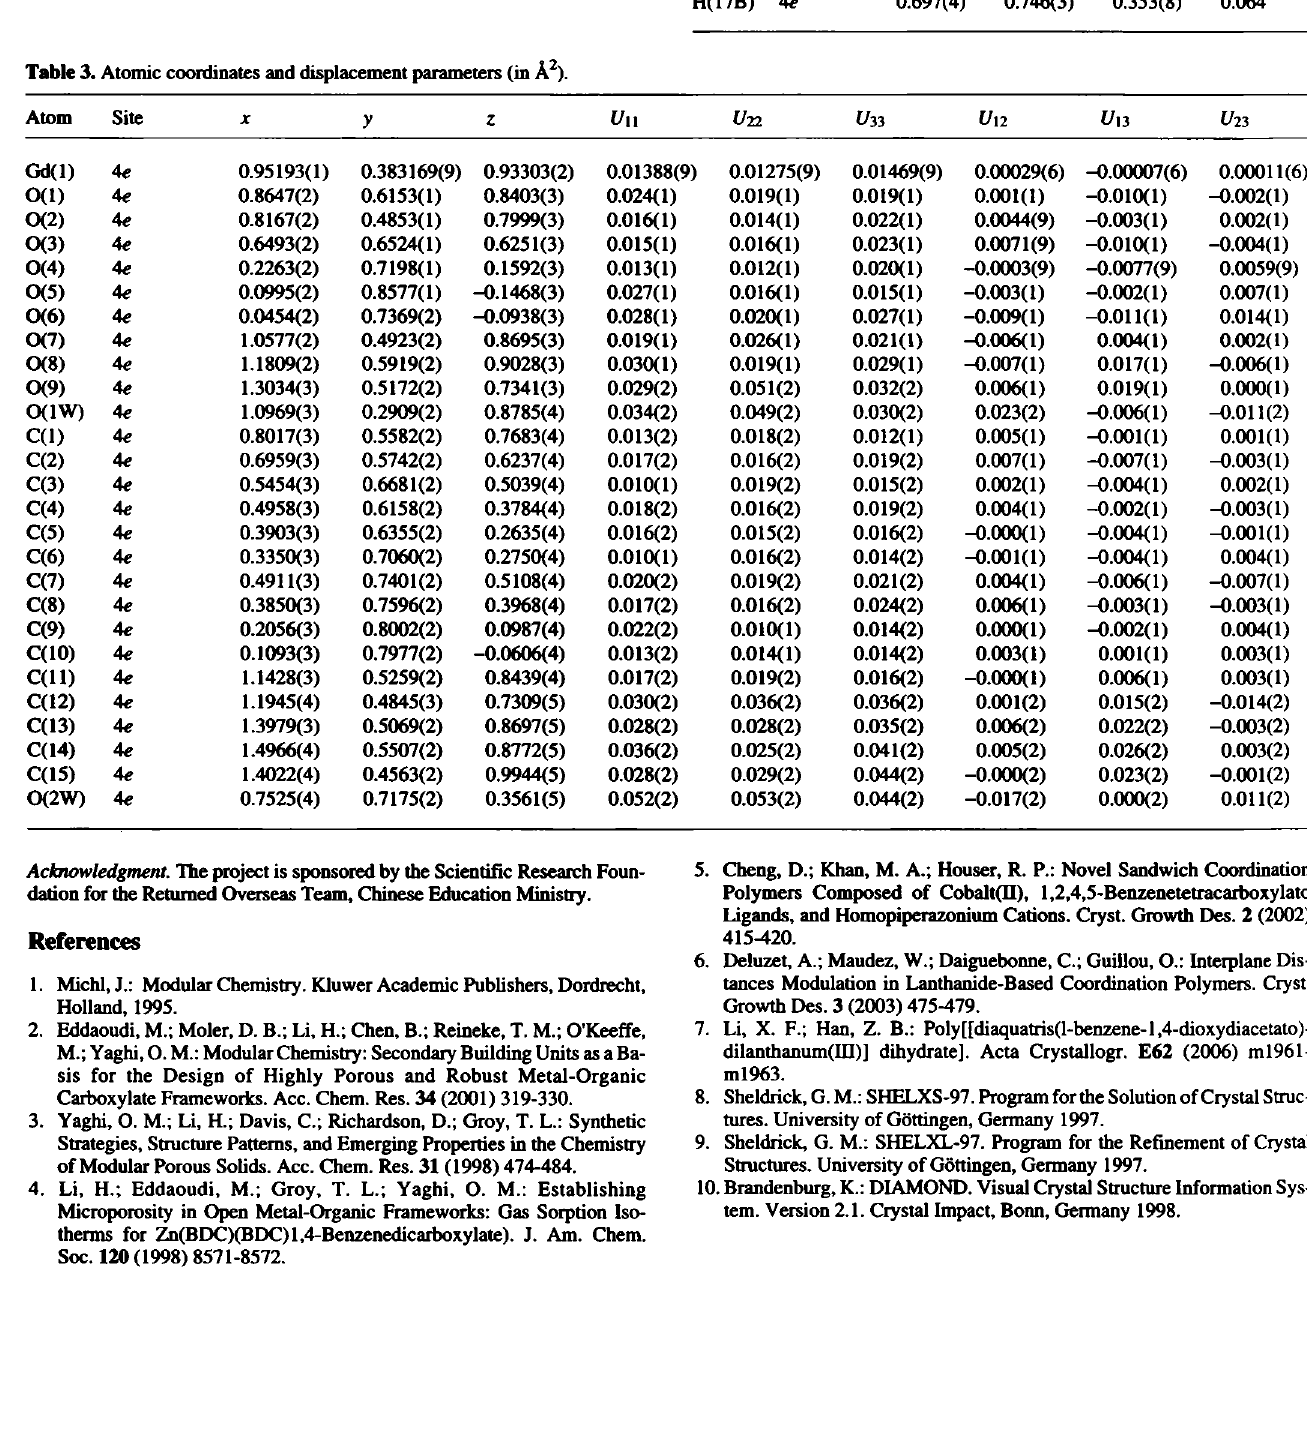
Table 3. Atomic coordinates and displacement parameters (in Â 2